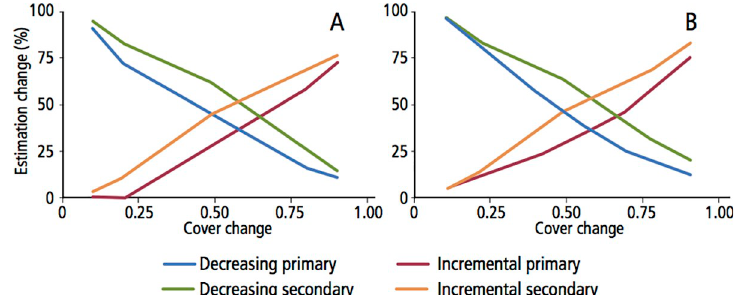
Fig 7. Sensitivity analysis of jaguar estimations in relation to changes in primary and secondary vegetation in the (A) 2010 and (B) 2018 censuses in Mexico. The thresholds for significant changes in our estimations are above 0.50 in all scenarios. This means that our jaguar population density estimations would change only if the vegetation changes would be over 50%, indicating the robustness of our